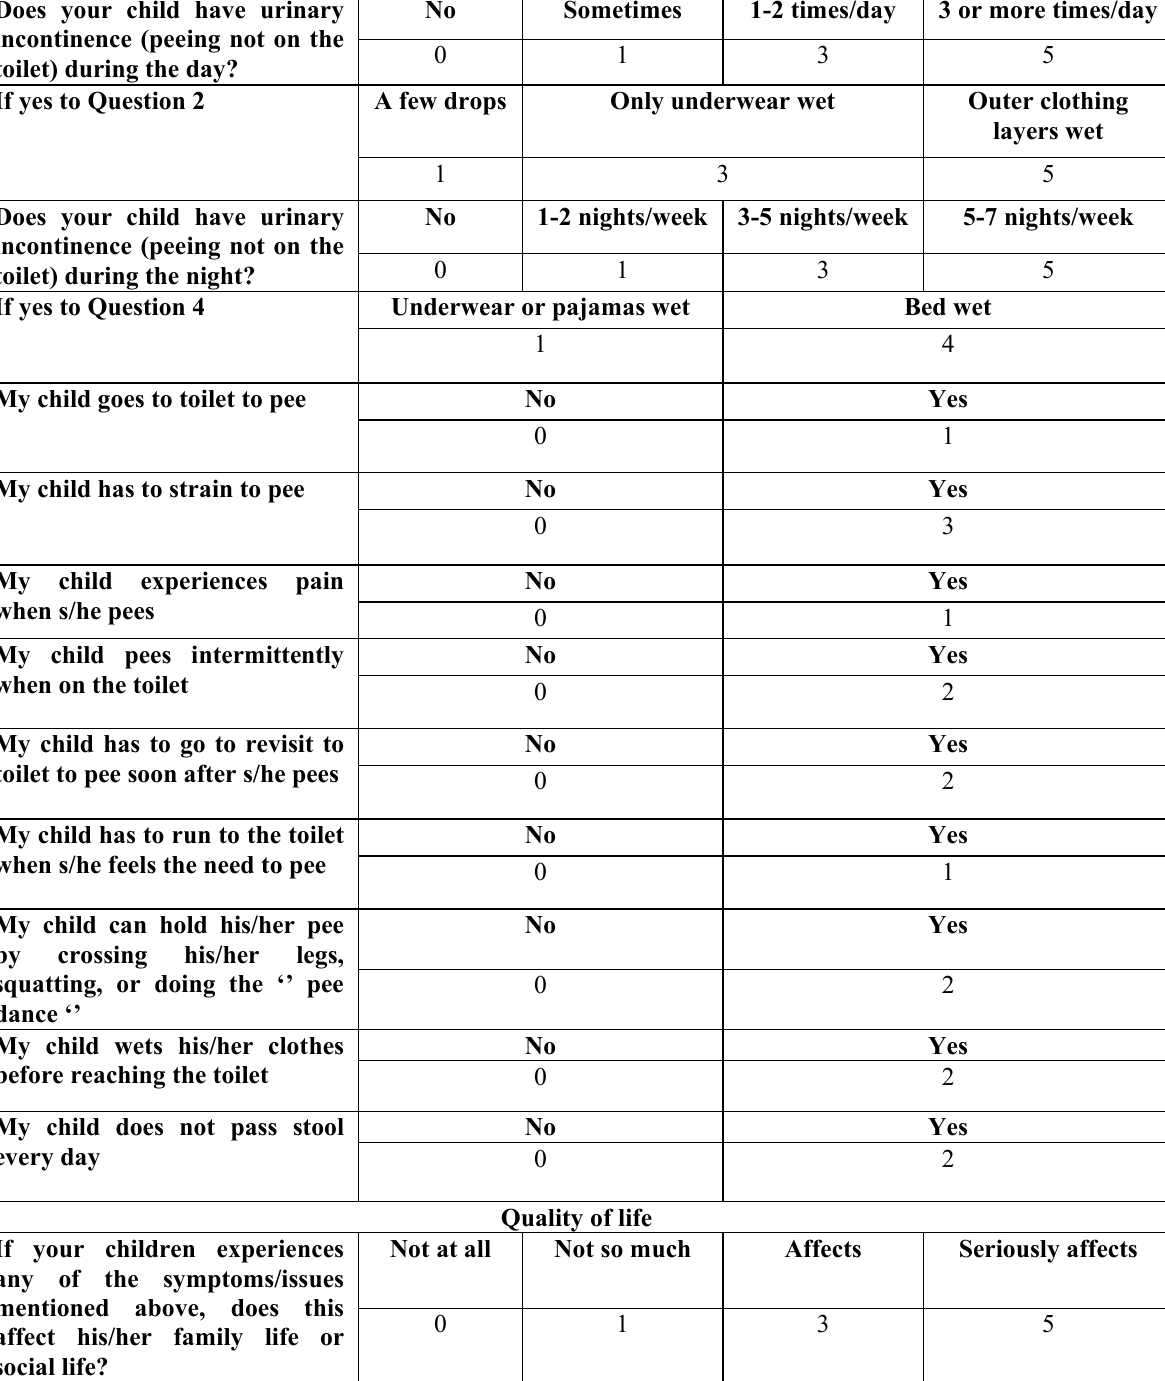
Figure 1 - The Dysfunctional Voiding and Incontinence Symptoms Score (DVISS) form for